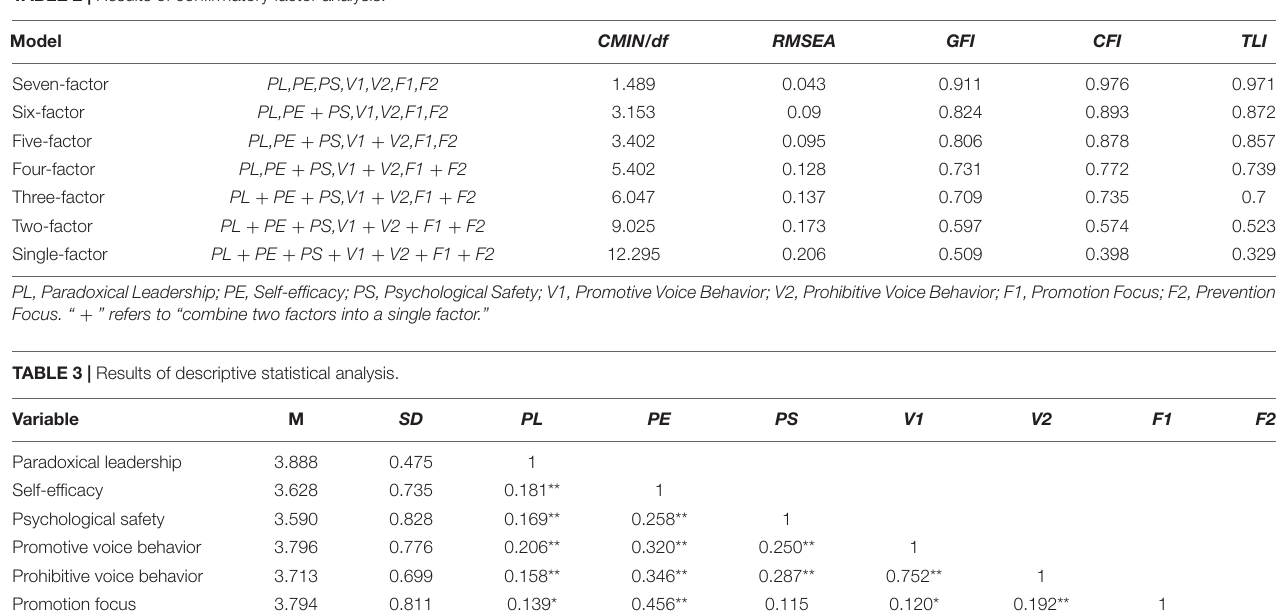
TABLE 2 | Results of confirmatory factor analysis.